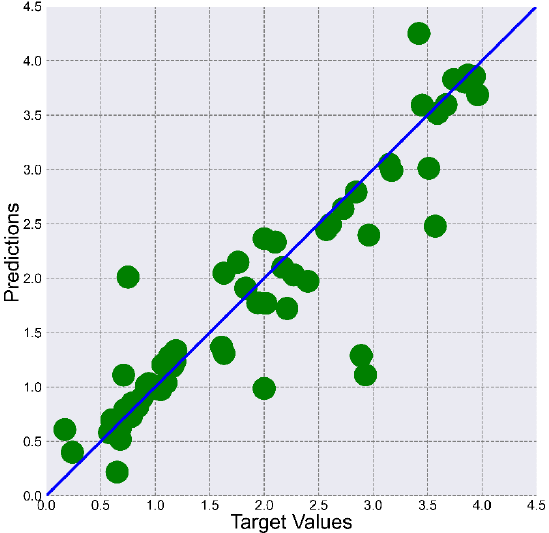
Figure 7. Scatter of predicted and target data values.